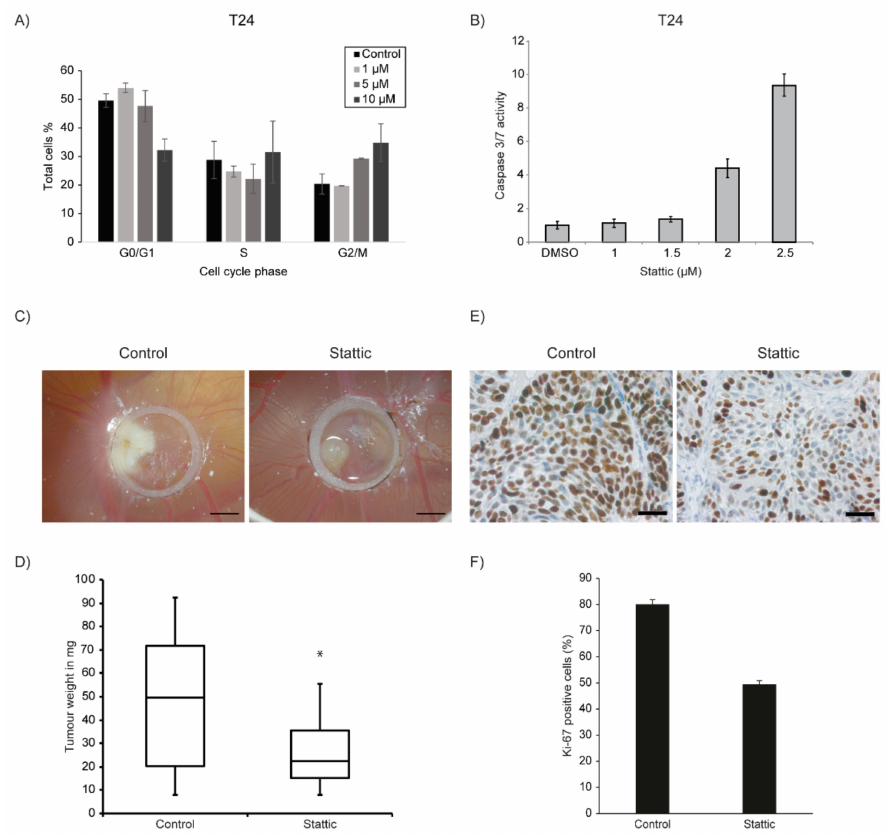
Figure 3. ( A ) Analysis of cell cycle progression in T24 treated with the indicated concentrations of Stattic for 24 h. An increase in G2 population was found with increasing concentration. ( B ) Caspase 3 / 7 assay for the apoptosis in T24 cells incubated for 24 h with the indicated concentrations of Stattic. The percentage of apoptotic cells was increased in a dose-dependent manner. ( C ) Stattic reduces the bladder cancer cell growth in vivo. Representative images of RT112 cells show tumour formation of Stattic versus control group on the CAM inside a silicone ring, 6 days after seeding of cells. Scale bar equals 2 mm. ( D ) Tumours from indicated cell line were harvested and weighed after Stattic ( n = 21) or control (DMSO) ( n = 19) treatment (‘*’ indicates p = 0.0069). ( E ) Tissue sections from the tumours were stained for Ki-67. ( F ) Number of Ki-67 positive cells were counted and compared between Control (DMSO) and Stattic-treated groups. Scale bar equals 4 µ m. Error bars